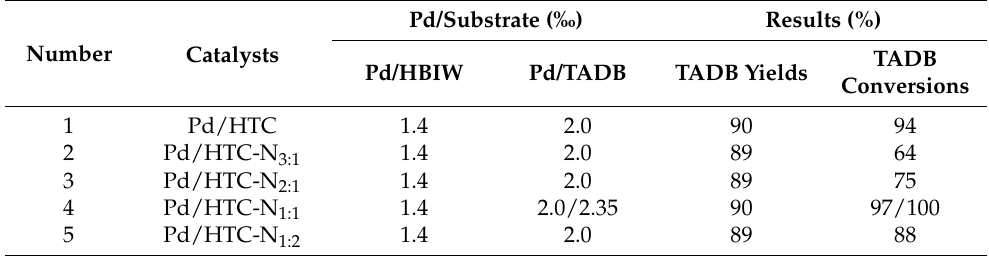
Table 3. Activities of the catalysts in the debenzylation reactions of HBIW and